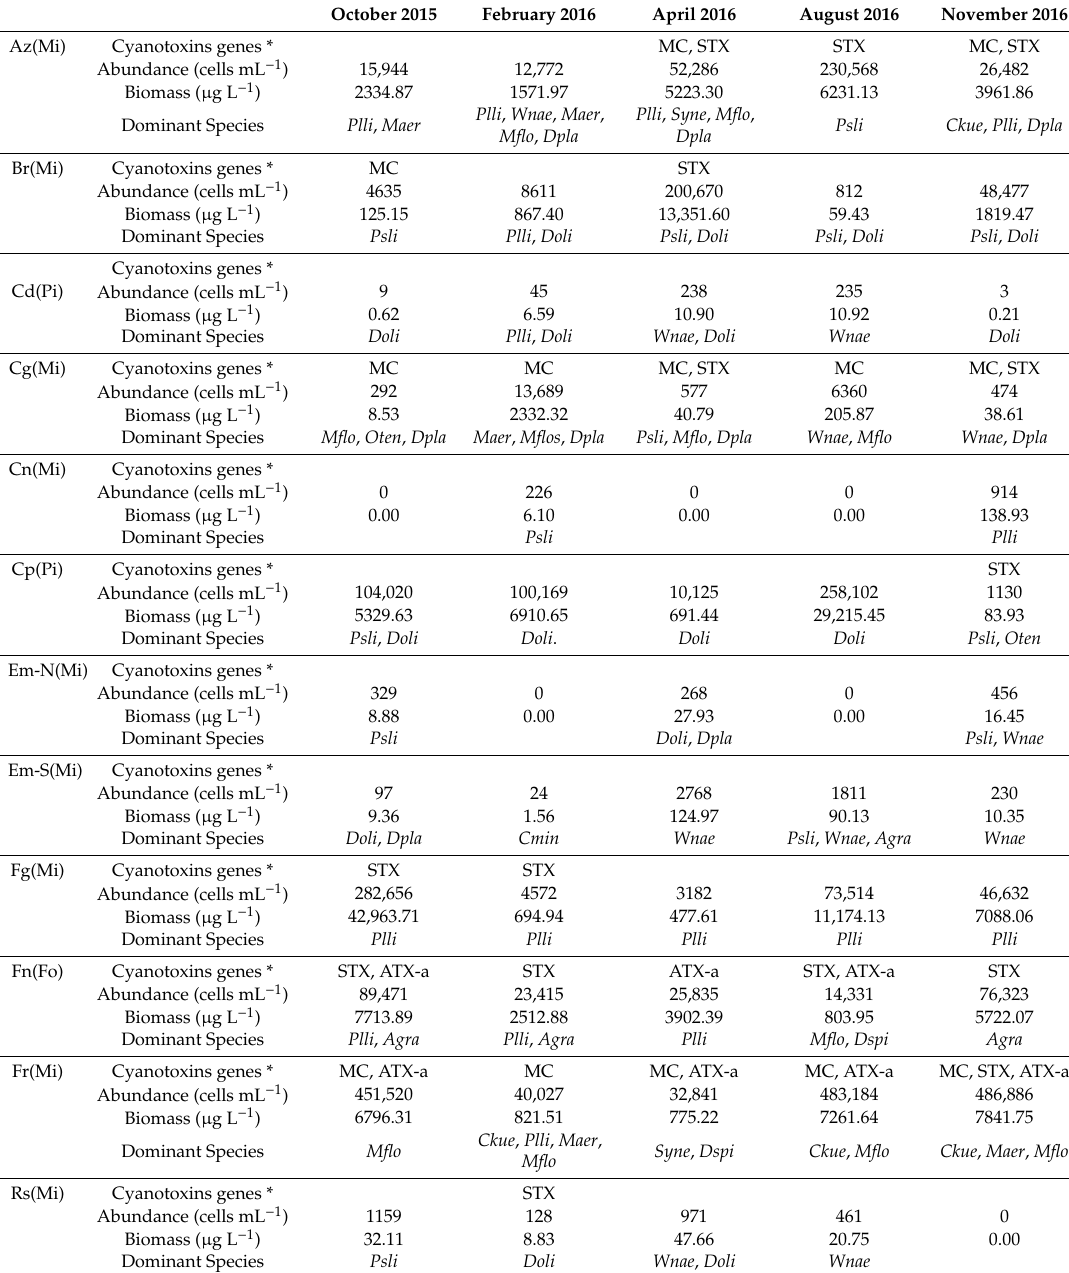
Table 3. Cyanotoxin-producing genes, cyanobacteria abundance, biomass, and dominant species ( > 2% of total cyanobacteria biomass) in the 15 sampled lakes, by sampling